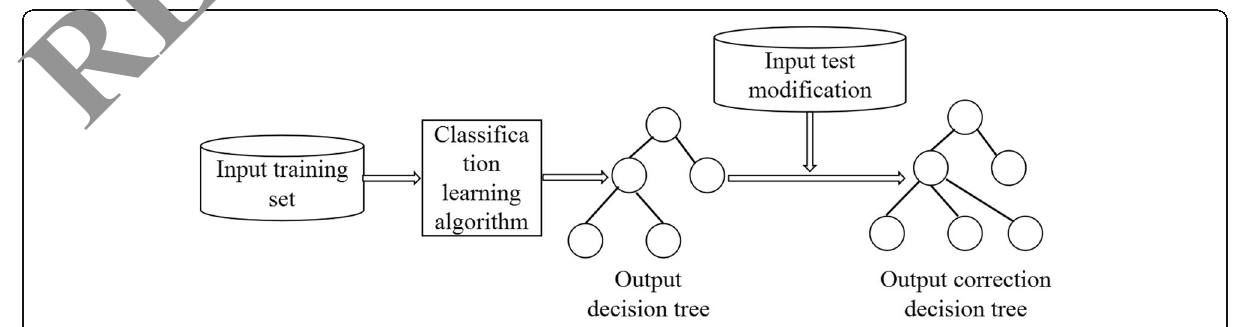
Fig. 2 A decision tree generation